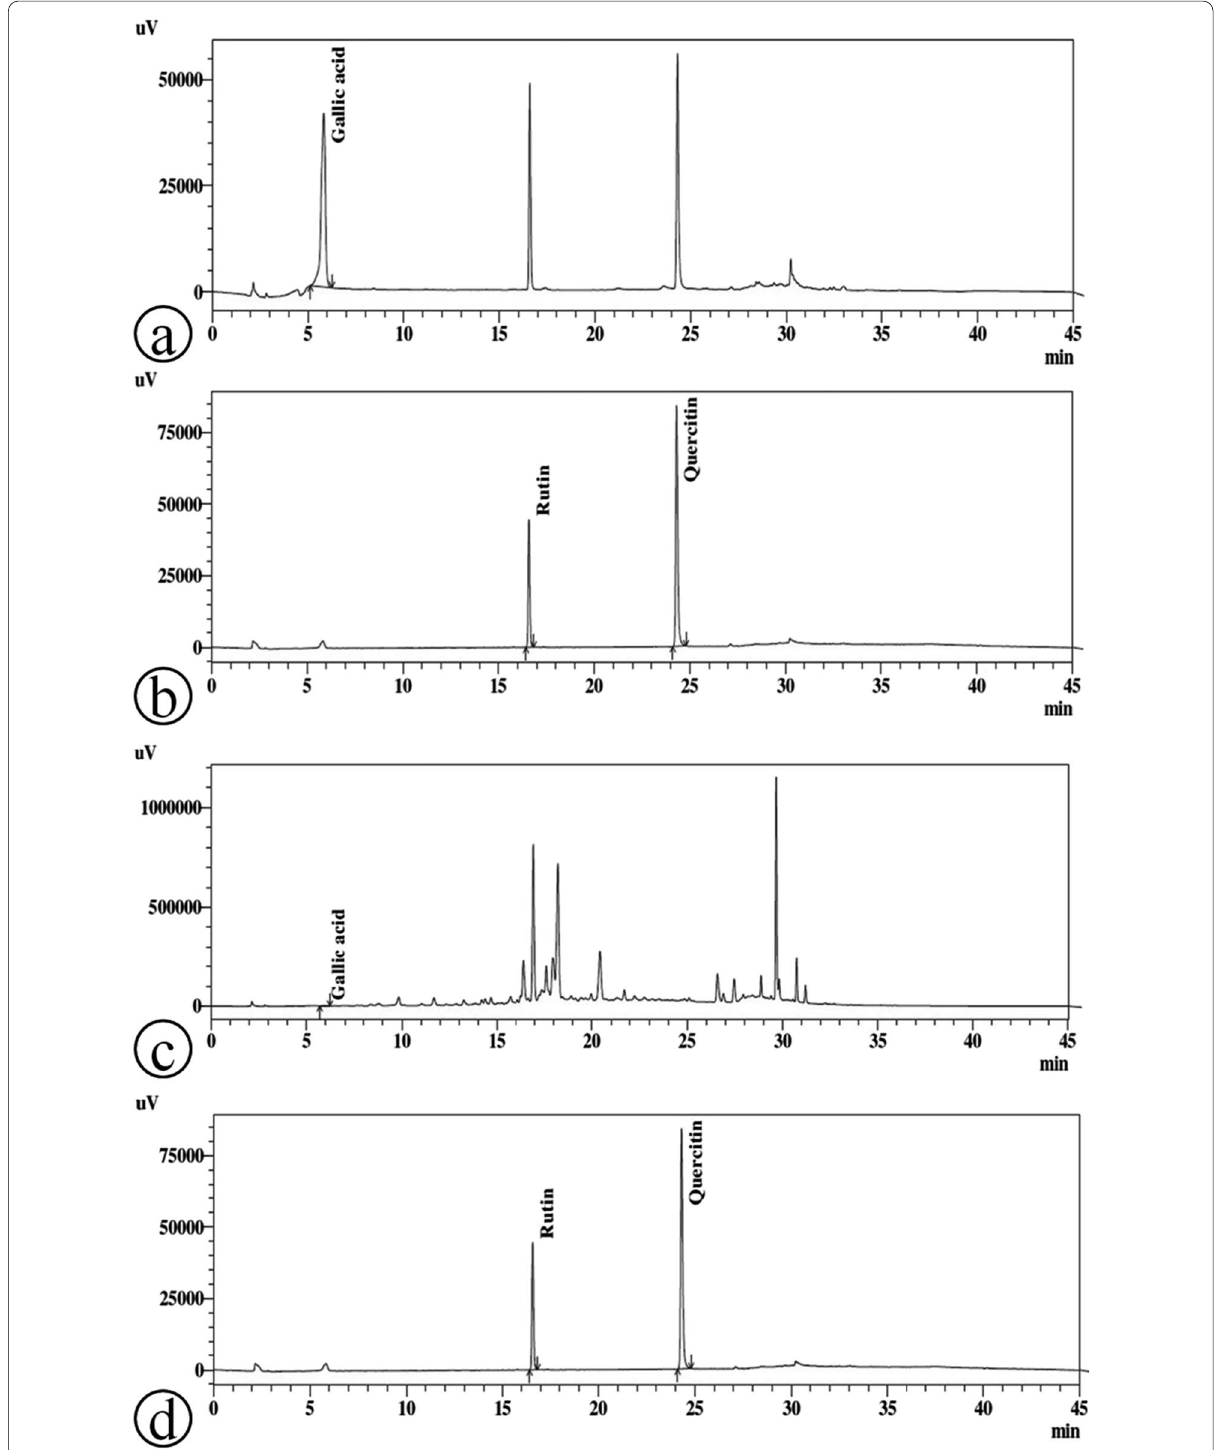
Fig. 1 HPLC chromatogram of a standard gallic acid; b standard rutin and quercetin; c gallic acid in ethanolic extract of L. rugosa ; d rutin and quercetin in ethanolic extract of L.